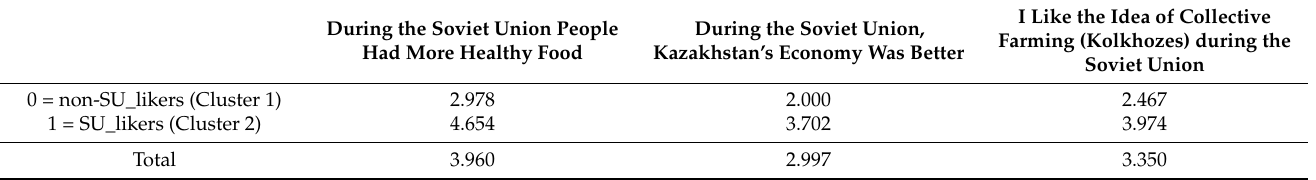
Table 4. Summary statistics (by mean) of the clusters.